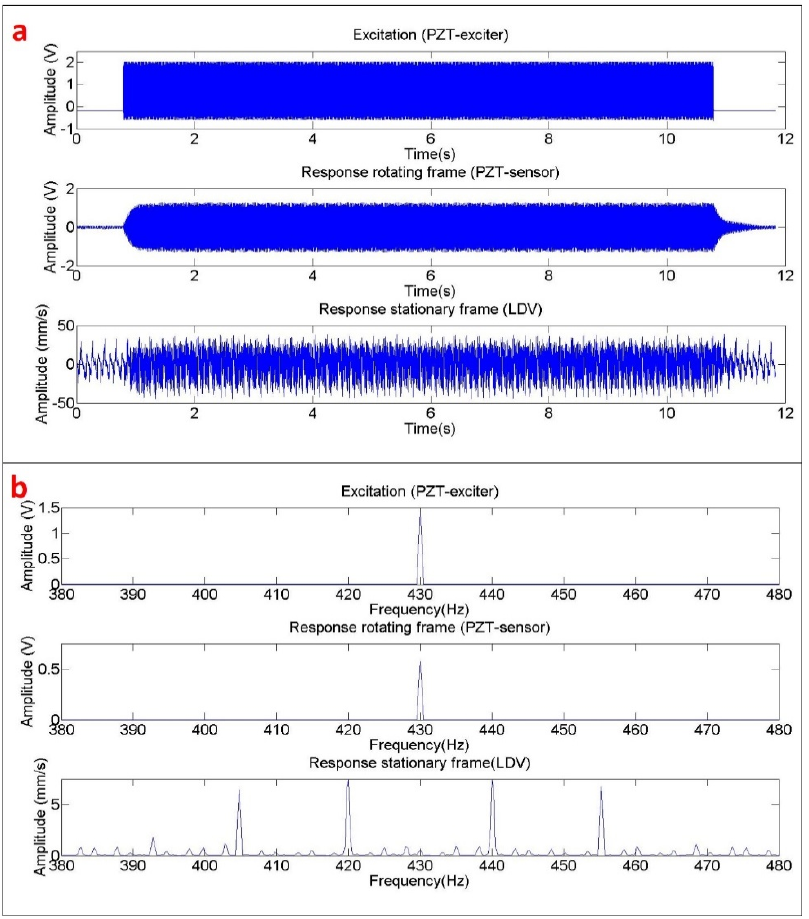
Figure 14. Excitation and response of the bladed-disk when exciting the third mode of Figure 11. PZT exciter, PZT sensor and LDV. ( a ) Time signals ( b ) Autospectrum.